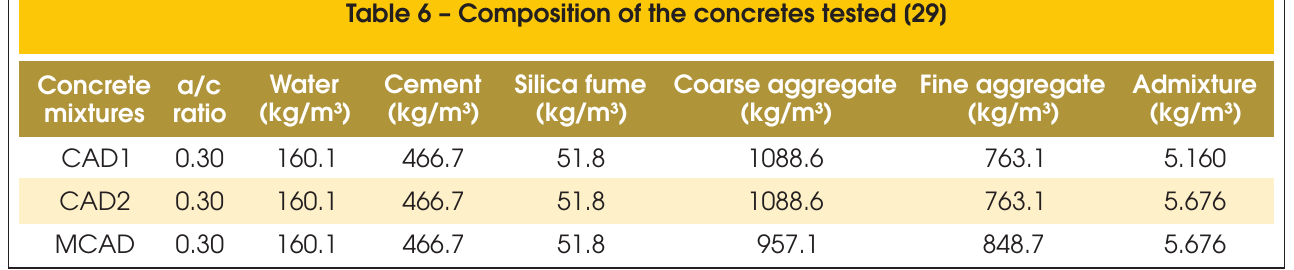
Table 6 – Composition of the concretes tested